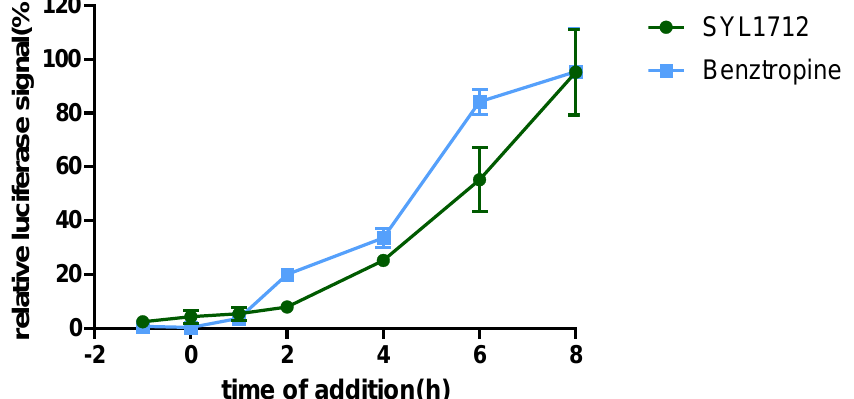
Figure 2. SYL1712 inhibits EBOV infection at late entry step. Pseudotyped HIV-1/EBOV was incubated with A549 cells at 4 ◦ C at the one-hour time point. After one hour of incubation, the pseudovirus was removed and temperature was shifted to 37 ◦ C to trigger virus internalization. SYL1712 (10 µ M) and benztropine (25 µ M) were introduced at different time points of virus infection, and the compounds’ effects on viral infection are shown (means ± SD; n = 3). The luciferase signals were normalized based on the signals from the vehicle DMSO-treated wells at each time point. Relative luciferase signal at 100% means the drug has no effect on the EBOV entry at each time point.